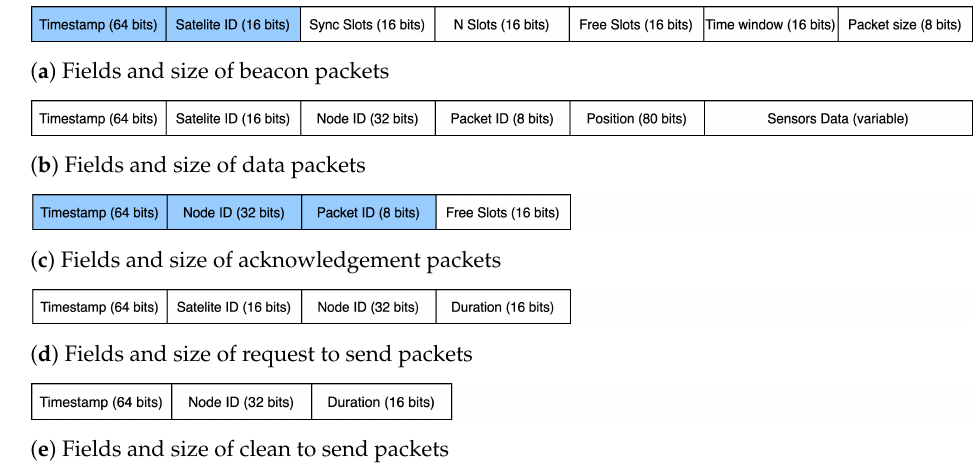
Figure 2. Format of the different packets defined.